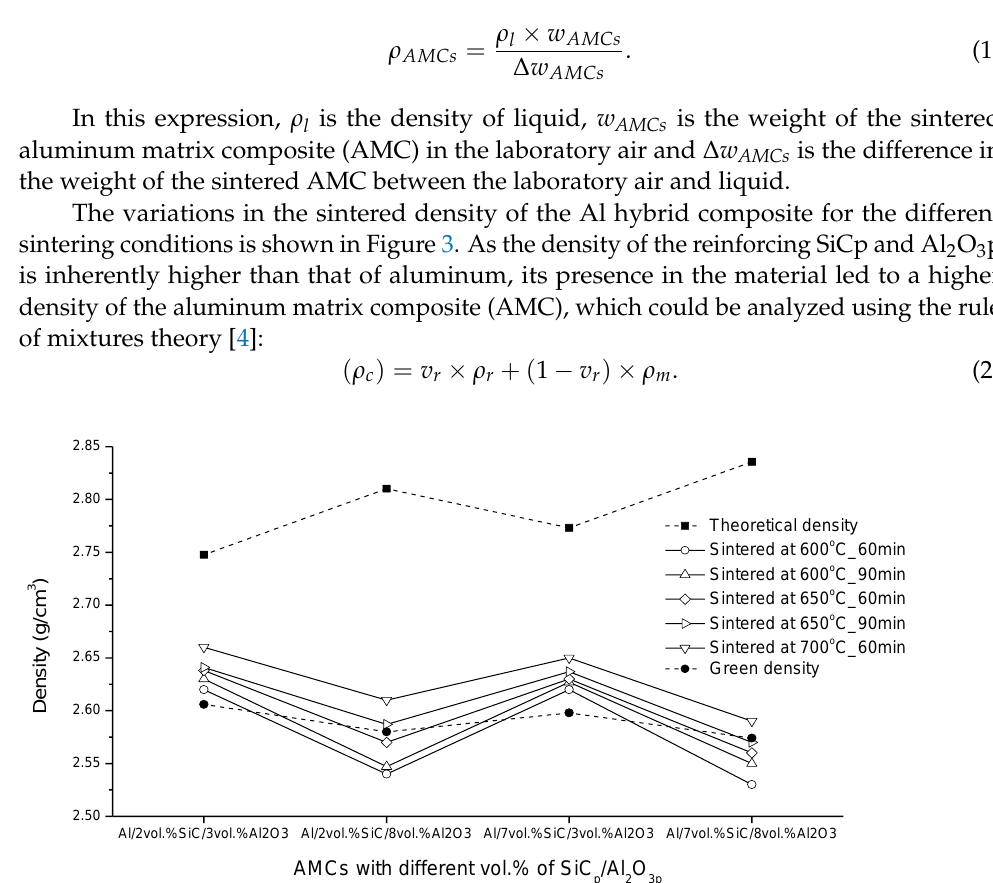
Figure 3. Effect of addition of SiC p /Al 2 O 3p on density for the different sintering conditions.